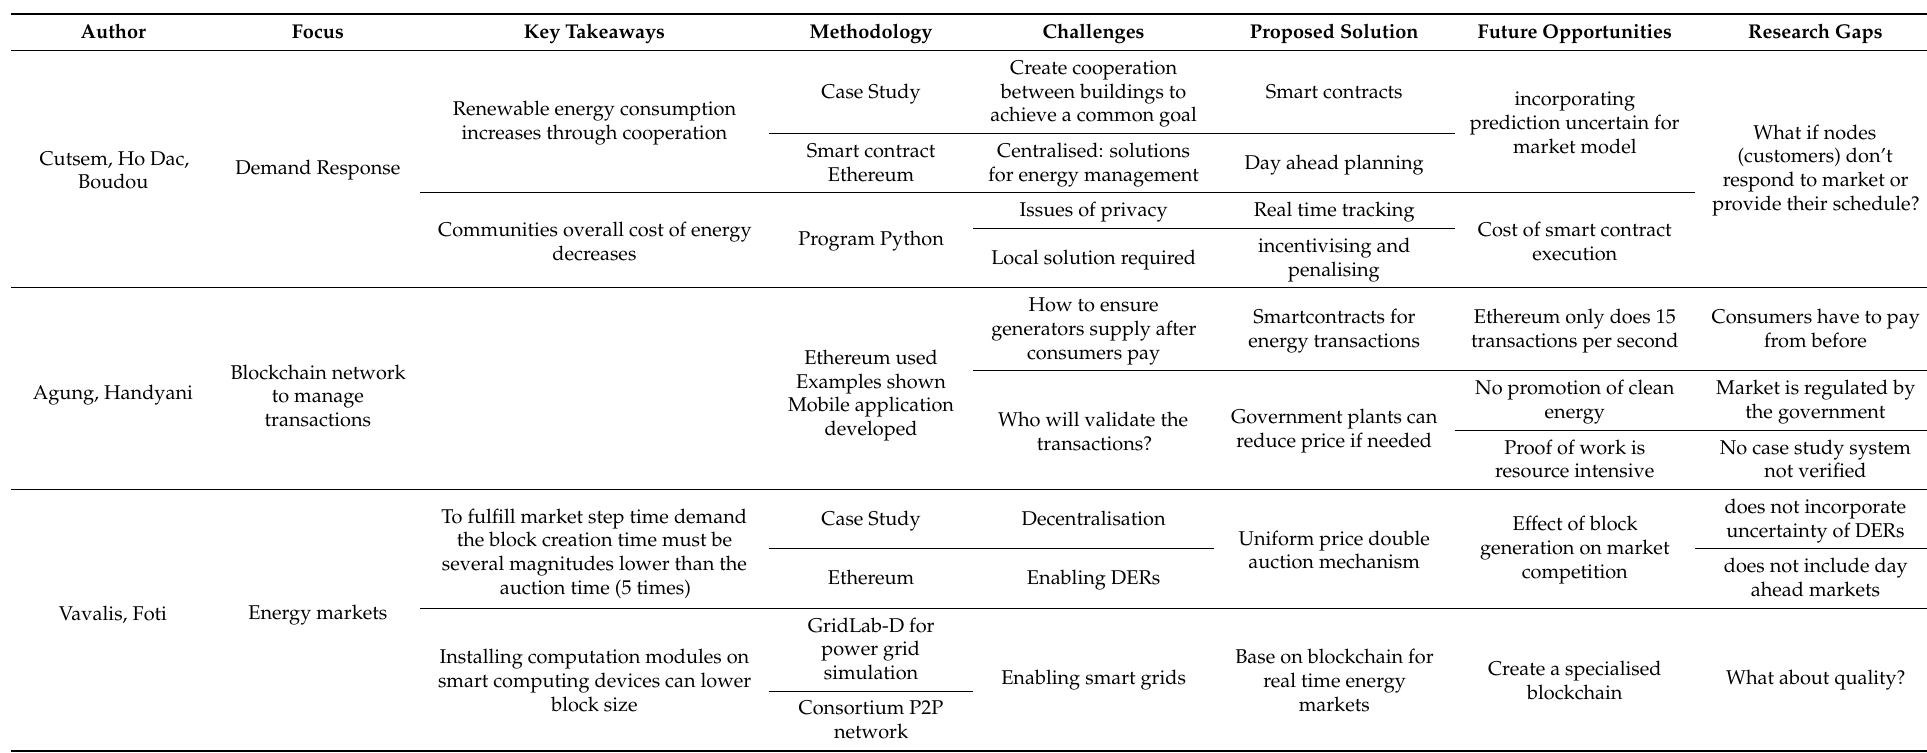
Table 3. A representative partial of the spread sheet used to analyze the information collected during the systematic literature review of 124 research